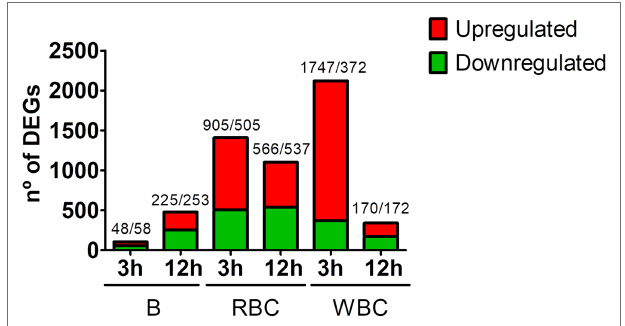
FIGURE 1 | Magnitude of the eel immune response against V. vulnificus represented as the number of differentially expressed genes (DEGs) in blood (B), red blood cells (RBCs) and white blood cells (WBCs) samples. Bars represent total DEGs (sum of upregulated [red] and downregulated [green] DEGs) of each sampling point (3 hpi; 12 hpi) against time zero (0 hpi) of each type of sample. The numbers of up/downregulated DEGs are indicated on the top of each